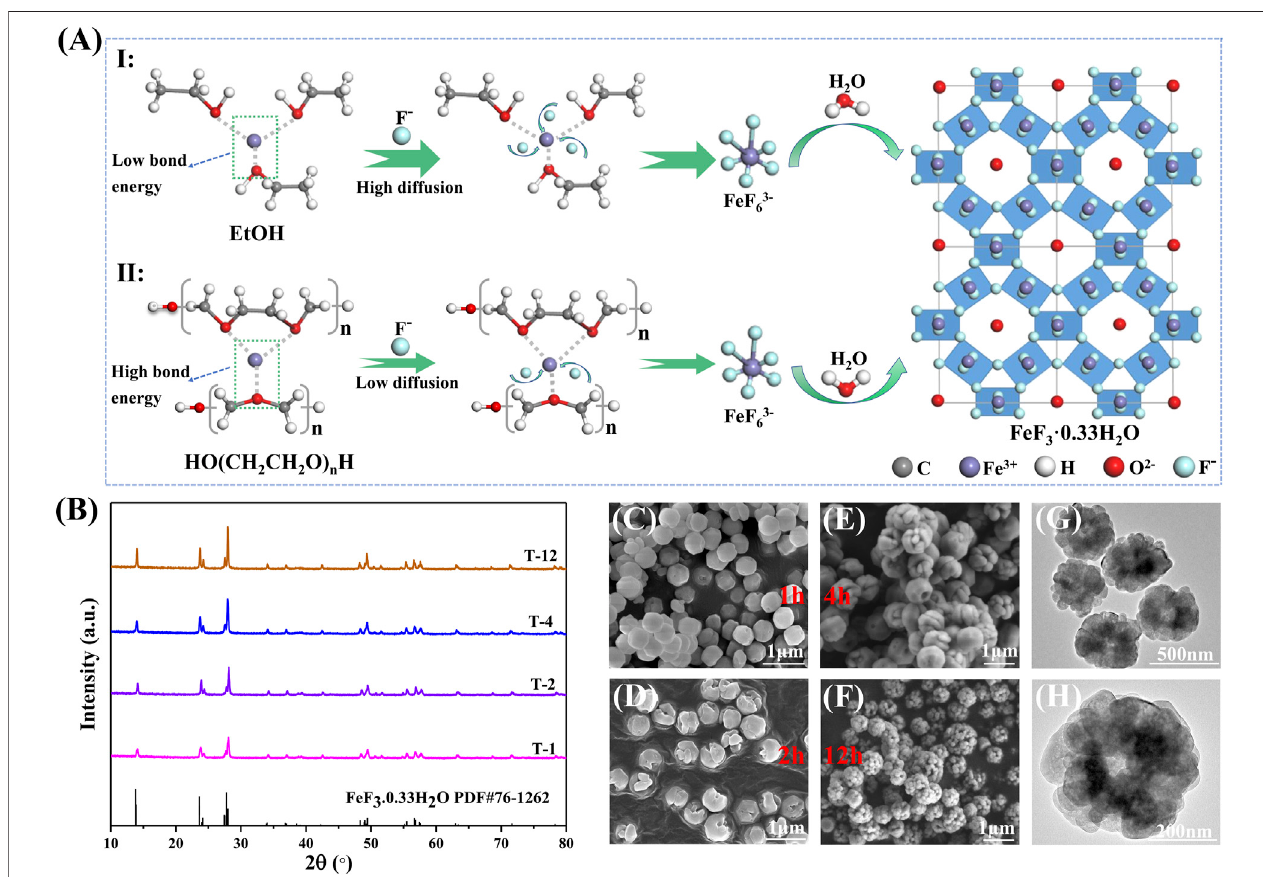
FIGURE 5 | (A) The two reaction routes with different proportions of solvents; inset: the unit cell of FeF 3 0.33H 2 O along the [100] direction. (B) XRD patterns of